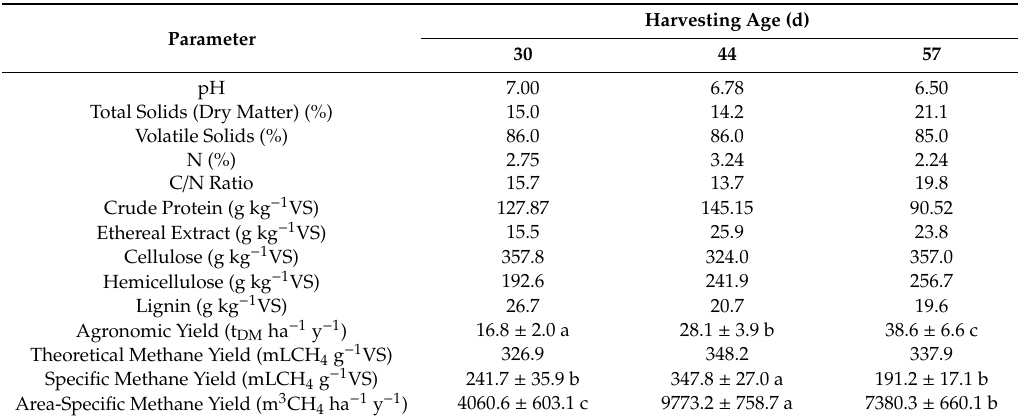
Table 1. Characterization and yields of King Grass according to harvesting age ( n = 3 where standard deviation is presented) (numbers of a same parameter followed by the same letter are not significantly di ff erent ( p =